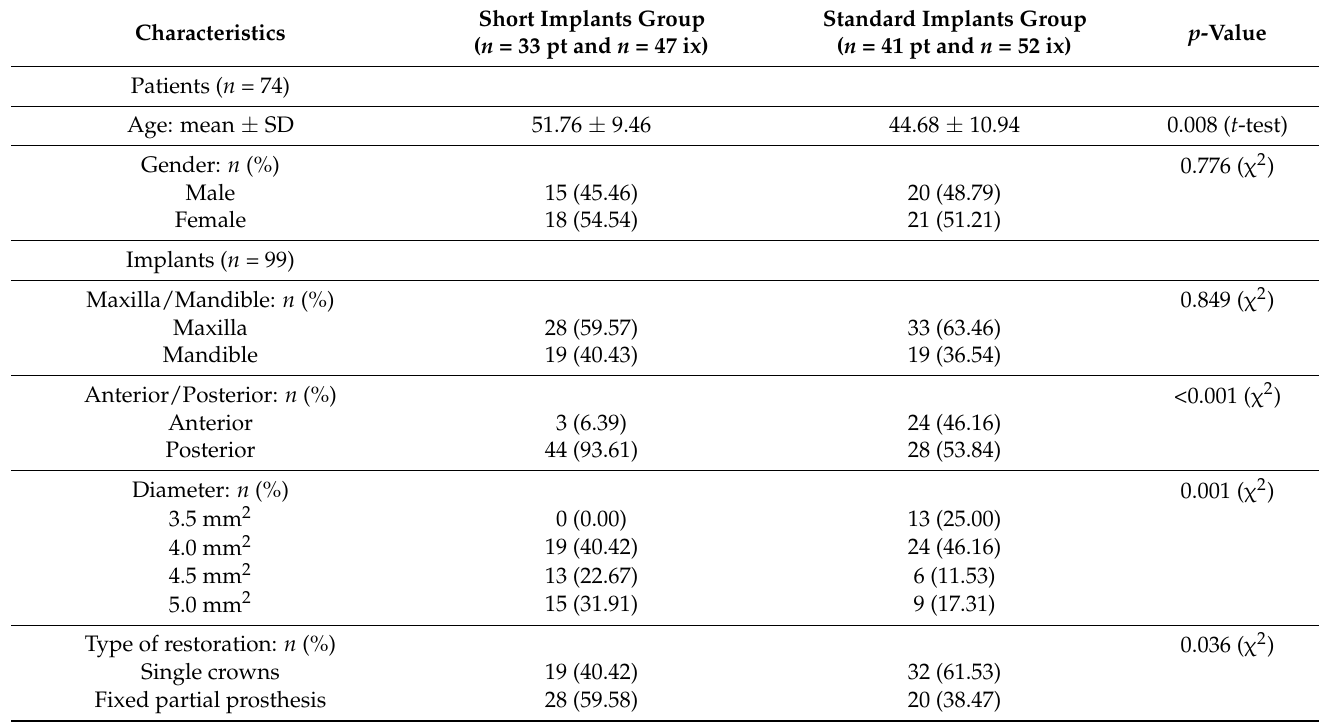
Table 1. Patients and implant characteristics. Homogeneity of the study groups in terms of the demographic characteristics and dental implants distribution (Student’s t and Pearson’s χ 2